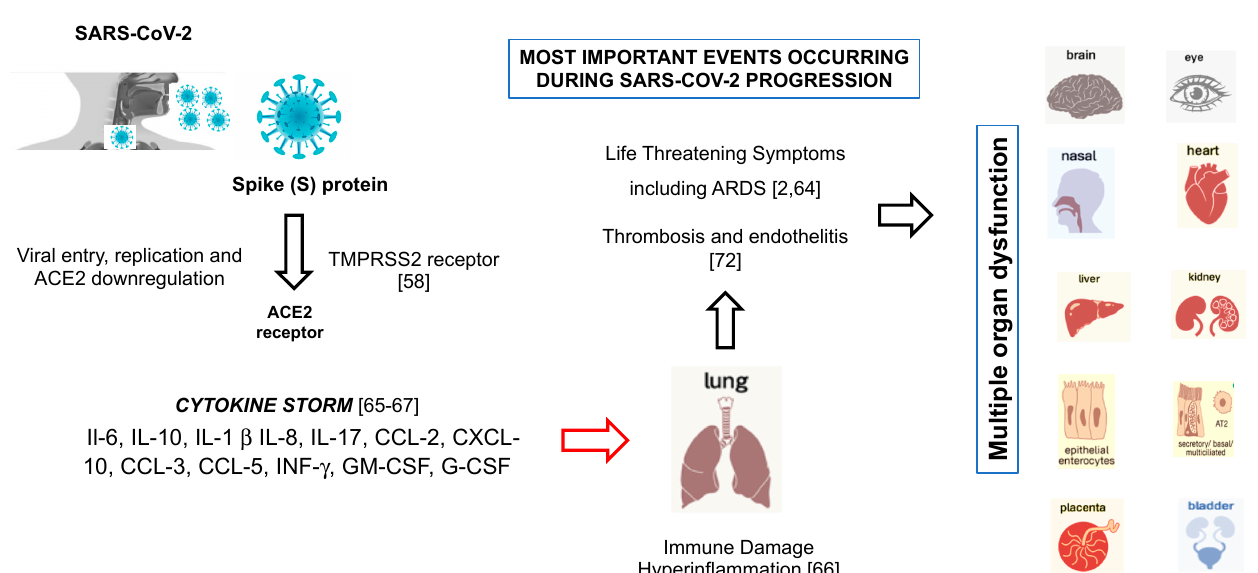
Figure 1. Angiotensin-converting enzyme 2 (ACE2) expression is also found in respiratory and pulmonary tract cells (alveolar monocytes and macrophages), with the possibility of severe acute respiratory distress syndrome (ARDS) and in heart, kidneys, brain, endothelium, liver, in which organ failure and thromboembolism may occur .